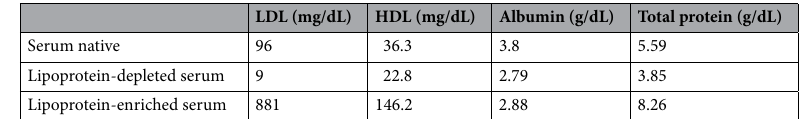
Table 2. Measured lipoprotein (LDL, HDL), albumin and total protein concentrations from native, lipoprotein-enriched and lipoprotein-depleted serum.